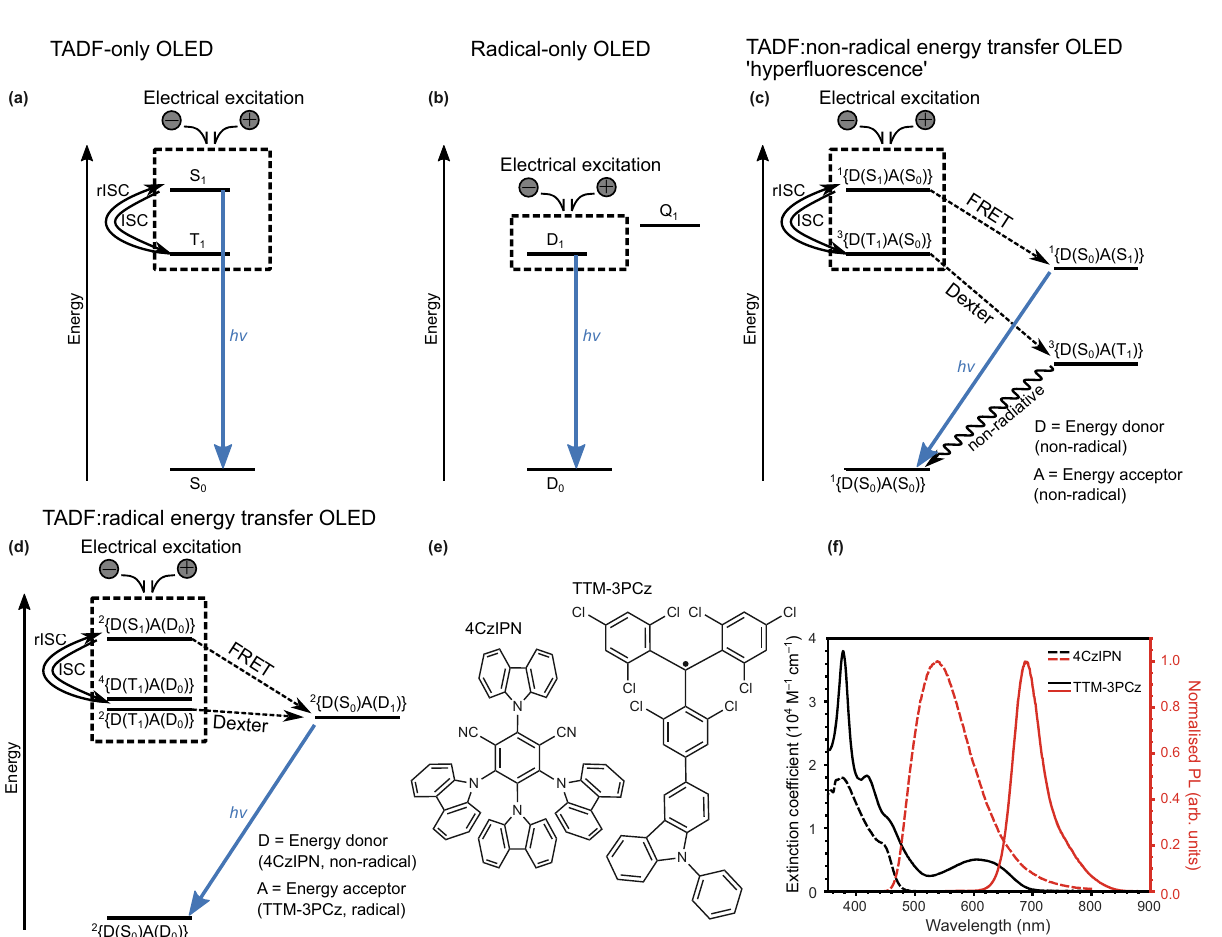
Fig. 1 Light emission mechanisms and the radical energy transfer system. Electroluminescence mechanisms for TADF-only, radical-only and energy transfer OLEDs. Spin-allowed radiative transitions from excited to ground states are indicated by blue arrows labelled ‘ hv . ’ a Scheme for TADF OLED mechanism with emission from singlet S 1 exciton, and singlet – triplet intersystem crossing (ISC) and reverse intersystem crossing (rISC) processes with non-emissive triplet T 1 exciton. b Scheme for radical OLED mechanism with emission from doublet D 1 exciton, formed by direct electrical excitation. Higher energy and non-emissive quartet Q 1 exciton state are shown. c Scheme for TADF:non-radical energy transfer OLED mechanism. Electrical excitation generates singlet D(S 1 ) and triplet D(T 1 ) excitons, with FRET singlet-singlet energy transfer to non-radical energy acceptor (A) to form emissive singlet excitons, A(S 1 ). Dexter triplet – triplet energy transfer forms non-emissive triplet excitons, A(T 1 ); non-radiative decay to the ground state is shown by a wavy arrow. ISC and rISC steps between D(T 1 ) and D(S 1 ) are indicated. Spin multiplicity of D and A pairs are denoted by 2 S + 1 in 2 S + 1 {D A}. d Scheme for TADF:radical energy transfer OLED mechanism. Electrical excitation generates singlet D(S 1 ) and triplet D(T 1 ) excitons, with singlet – doublet FRET and triplet – doublet Dexter energy transfer to radical energy acceptor (A) to form emissive doublet excitons, A(D 1 ). e Chemical structures for 4CzIPN and TTM-3PCz used to test the mechanism in ( d ). f Absorption (black) and normalised PL (red) pro fi les for 4CzIPN (dotted lines) and TTM-3PCz (solid